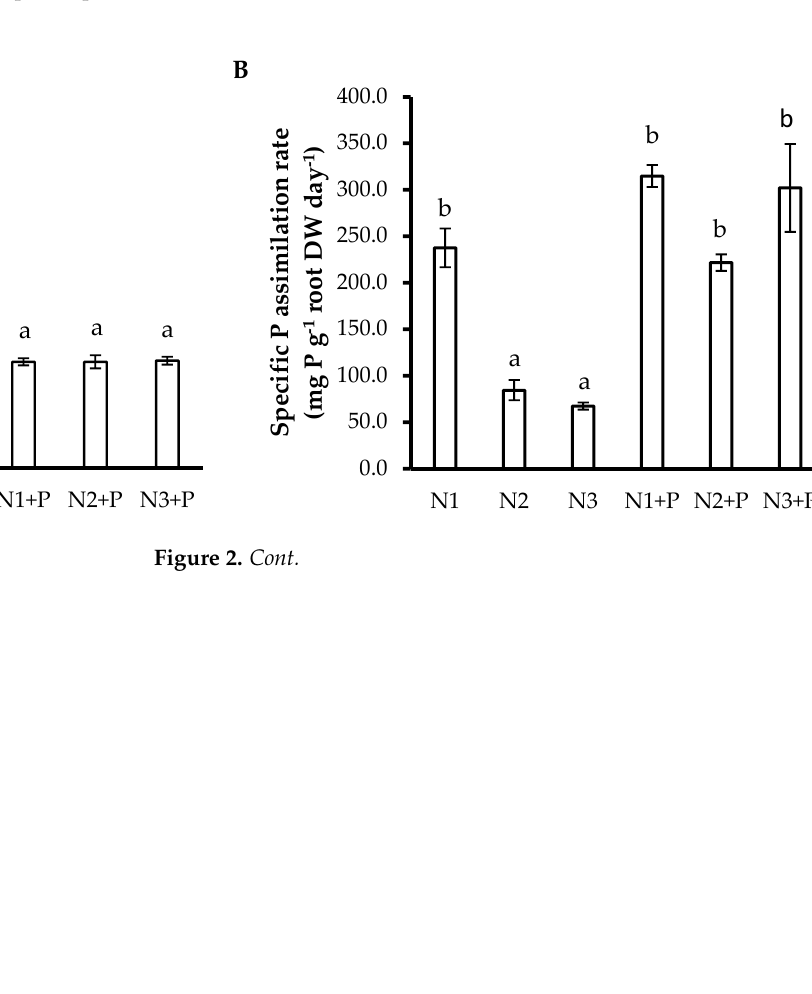
Figure 1. ( A ) Growth rate (g DW day − 1 ); ( B ) Relative growth rate (ln DW increase day − 1 ); ( C ) Carbon construction costs (mmol C g − 1 DW) of 180-day-old L. leucocephala saplings grown in Veld Fertilizer Trial soils from Ukulinga Experimental Farm, South Africa. The values represent the mean ± SE, based on n = 5. Significant differences among treatments ( p < 0.05) are denoted by different superscript letters.